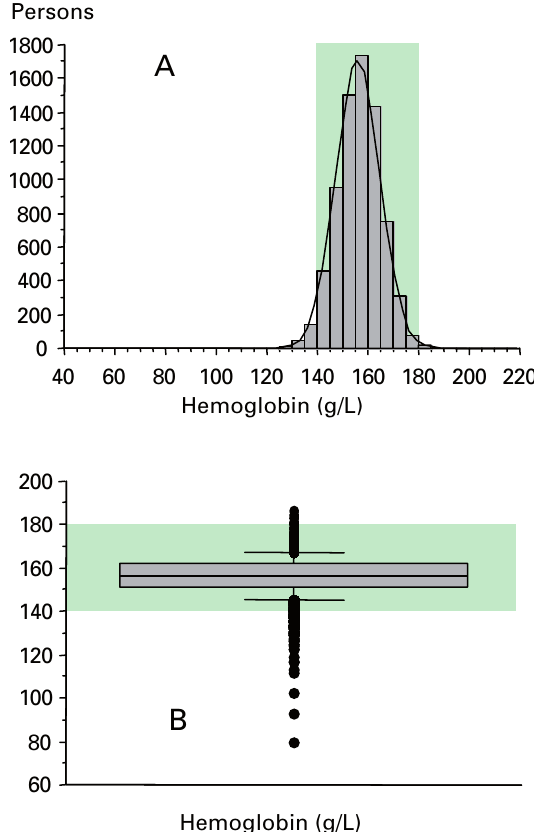
Figure 1 Myeloproliferative disorder, essential thrombocytosis. One draftee pre- sented with markedly elevated levels of thrombocytes (1636 G/L) and border- line elevated levels of neutrophils (7.72 G/L), while his CRP was <3 mg/L. Giant thrombocytes and hyper-seg- mented neutrophils could be demon- strated in his blood smear (A, May-Grün- wald Giemsa), and giant megakaryo- cytes were found in his bone marrow (biopsy, B). Chronic myeloid leukemia was ruled out both by PCR and cyto- genetics (data not shown).